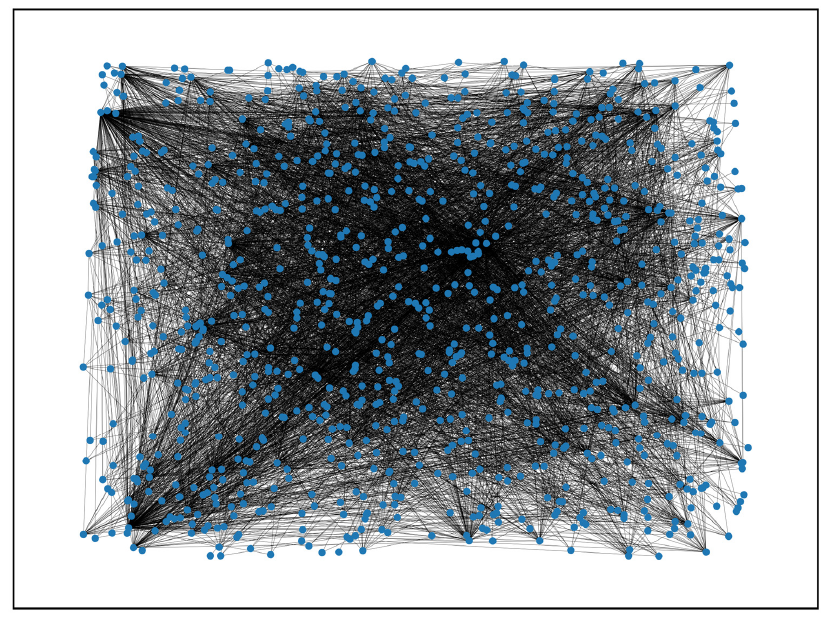
Figure 7. The first thousand nodes are in the Bitcoin Alpha trust weighted signed